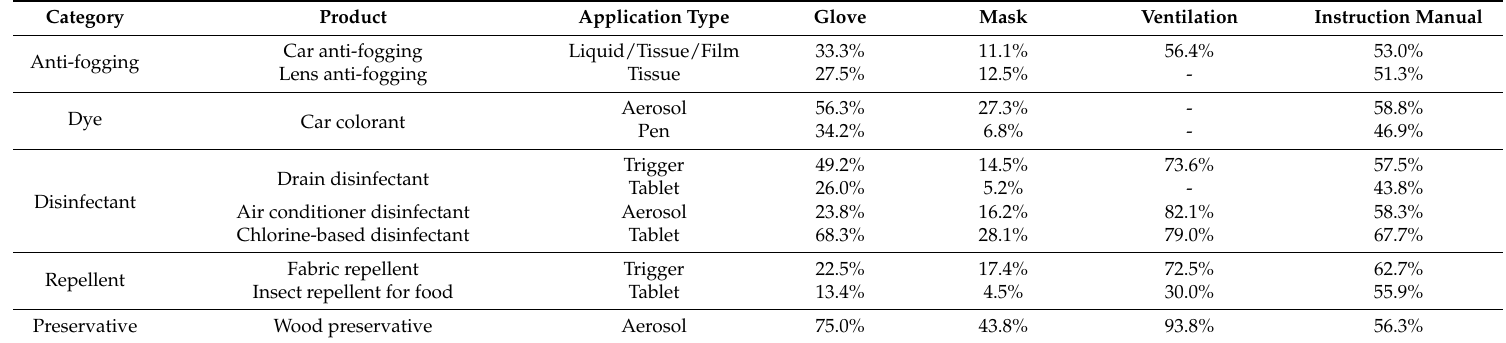
Table 4. Protective actions taken to reduce exposure during product